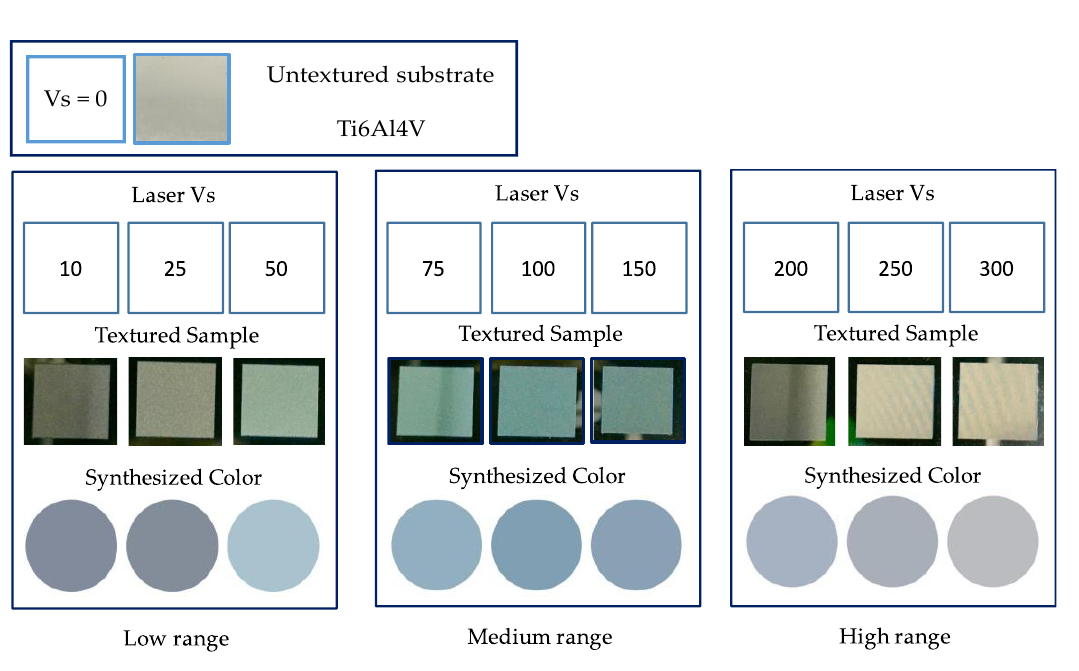
Figure 7. Color palette generated under different scanning speeds.